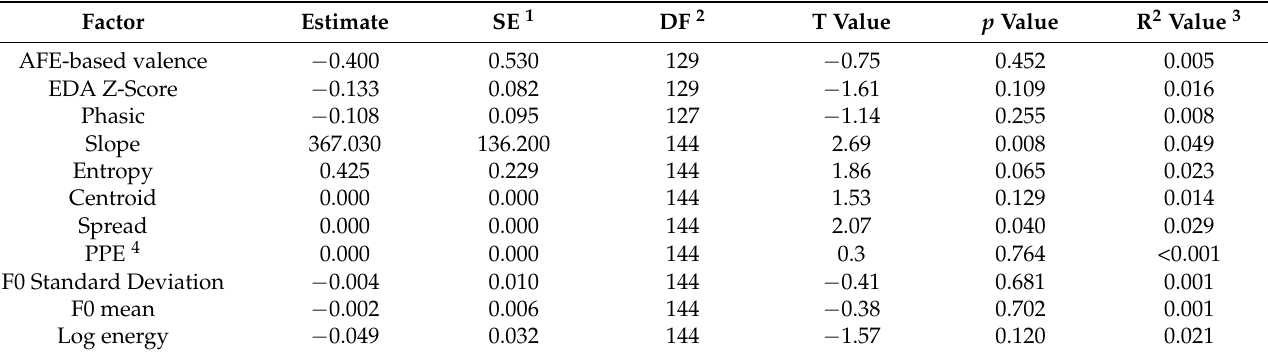
Table 7. Regression results of Control